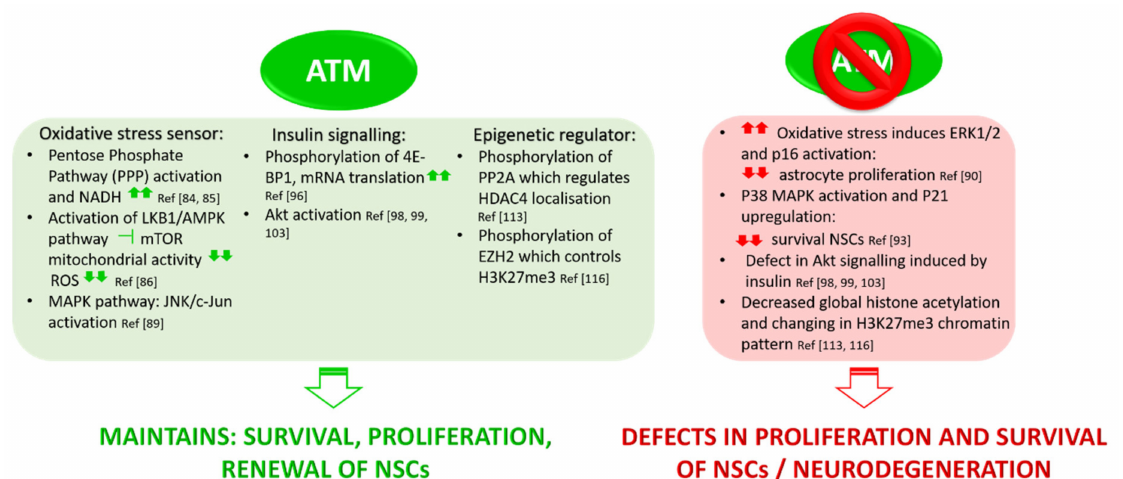
Figure 3. ATM maintains NSCs’ survival and protects from neurodegeneration. Through its roles in the maintenance of oxidative stress homeostasis, insulin signalling pathways, and epigenetic regulation, ATM is involved in survival, proliferation, and renewal of neuronal stem cells (NSCs). In ATM deficiency, neural progenitors show a reduced survival rate and defects in proliferation and di ff erentiation. ATM absence also a ff ects the proliferation of astrocytes, which in turn fail to support neuronal homeostasis, leading to neurodegeneration.